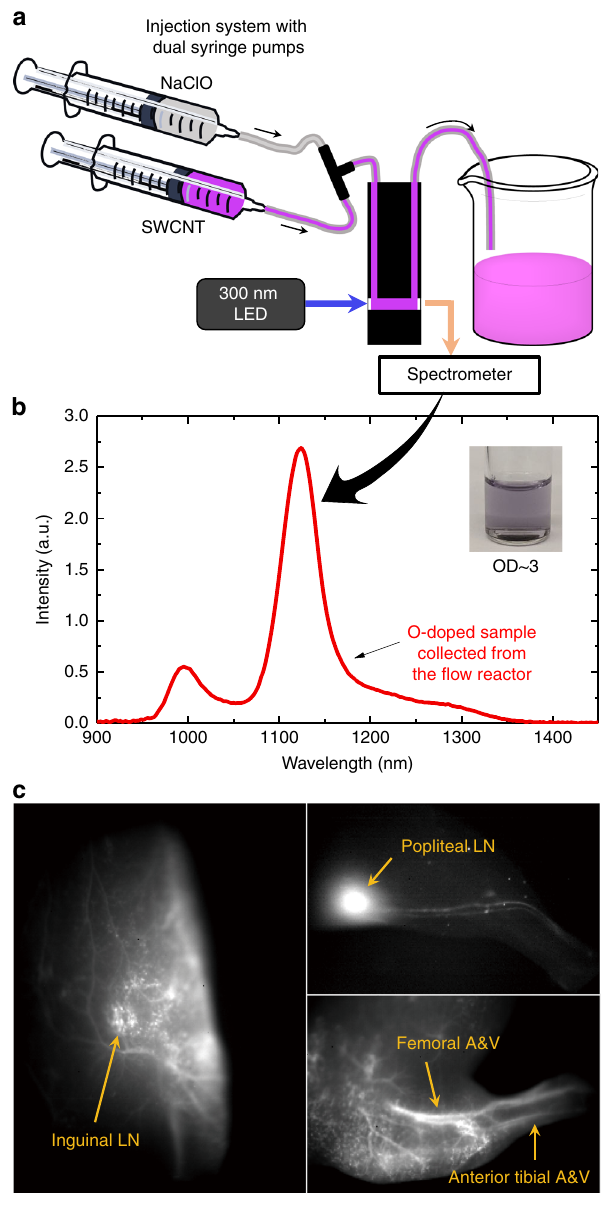
Fig. 5 Ef fi cient synthesis of O-doped SWCNTs and their application in fl uorescence in vivo imaging. a Schematic diagram of the fl ow reactor incorporating syringe pumps and a 300 nm LED for irradiation and fl uorescence excitation. Emission was collected through the back cell window and analyzed in a SWIR spectrometer. b Emission spectrum of O- doped SWCNTs synthesized in the fl ow reactor. The solution was diluted by SDC to OD ~0.1 for measurement. (Inset) Photo of O-doped (6,5)- SWCNTs collected directly from the fl ow reactor. c SWIR fl uorescence images of O-doped SWCNTs in vivo. Left panel: a black mouse injected intravenously with ~100 ng of O-doped SWCNTs, showing clear inguinal lymph node. Upper right panel: lymphatic drainage after footpad injection (~10 ng) into a white mouse. Lower right panel: clear vasculature imaging from the leg of a black mouse injected with ~100 ng of O-doped